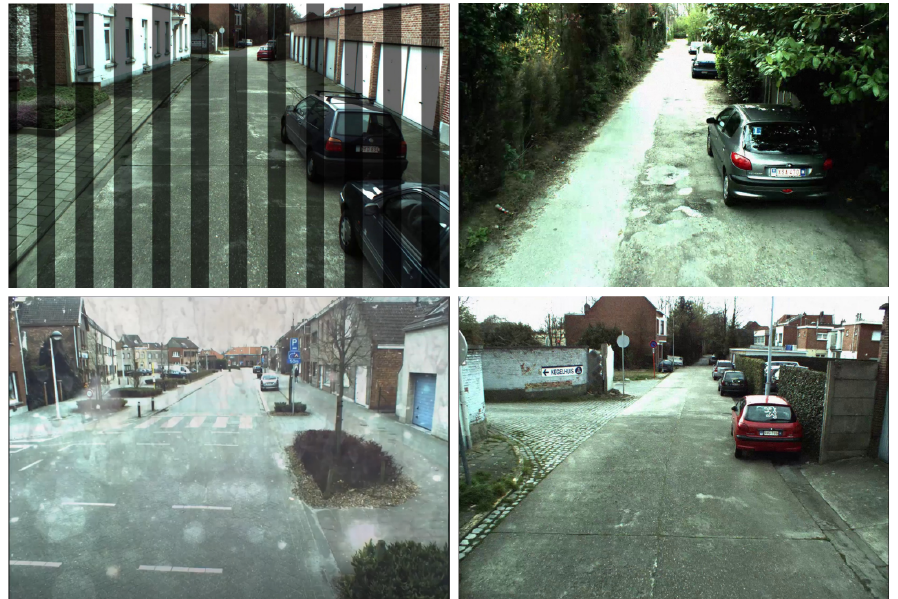
Figure 5. Dataset samples taken from CURE-TSD. Heavy augmentation is applied to increase challenge for object detection